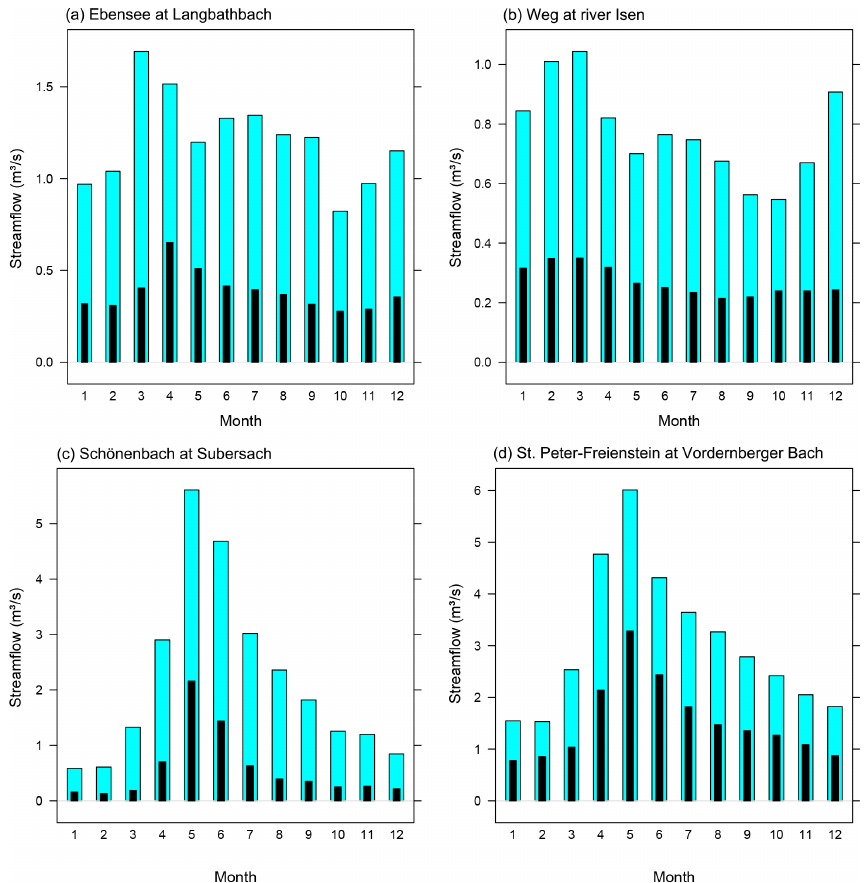
Figure 3. Monthly hydrographs of the example gauges (Fig. 1). (a) Ebensee at river Langbathbach, (b) Weg at river Isen, (c) Schönenbach at river Subersach, and (d) gauge St. Peter-Freienstein at river Vordernberger Bach. Shown is the mean (blue) and the 10th percentile (black) of daily